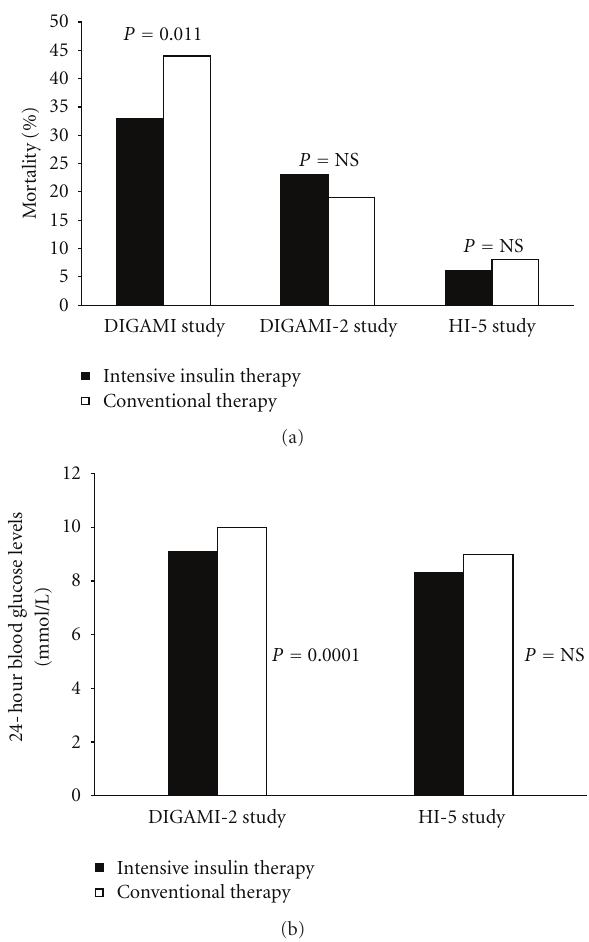
Figure 2: (a) Mortality benefit of intensive insulin therapy over conventional therapy in clinical trials. (b) Reduction in 24 hour blood glucose levels with intensive insulin therapy over conven- tional therapy in clinical